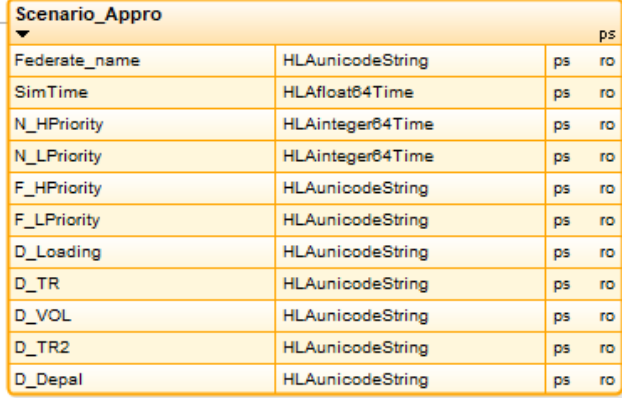
Figure 12. HLA object: supply delivery parameters.